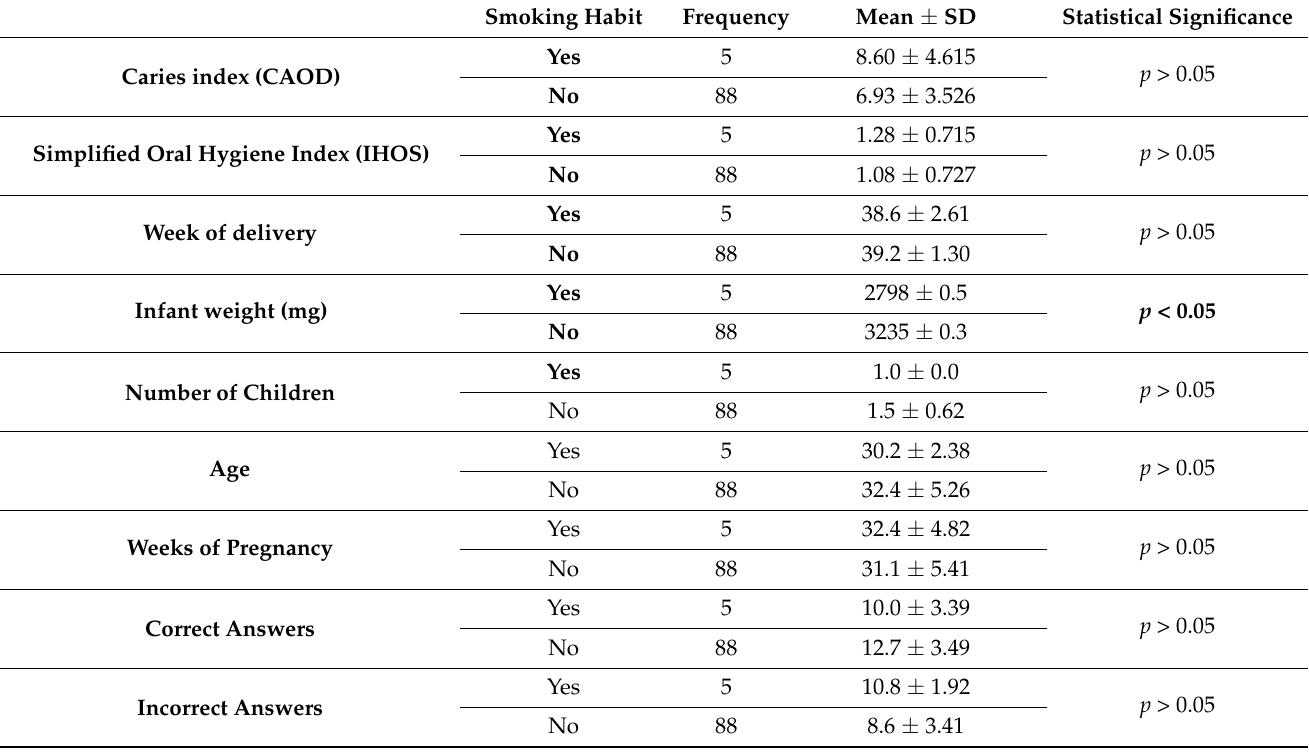
Table 6. Results of different variables according to smoking